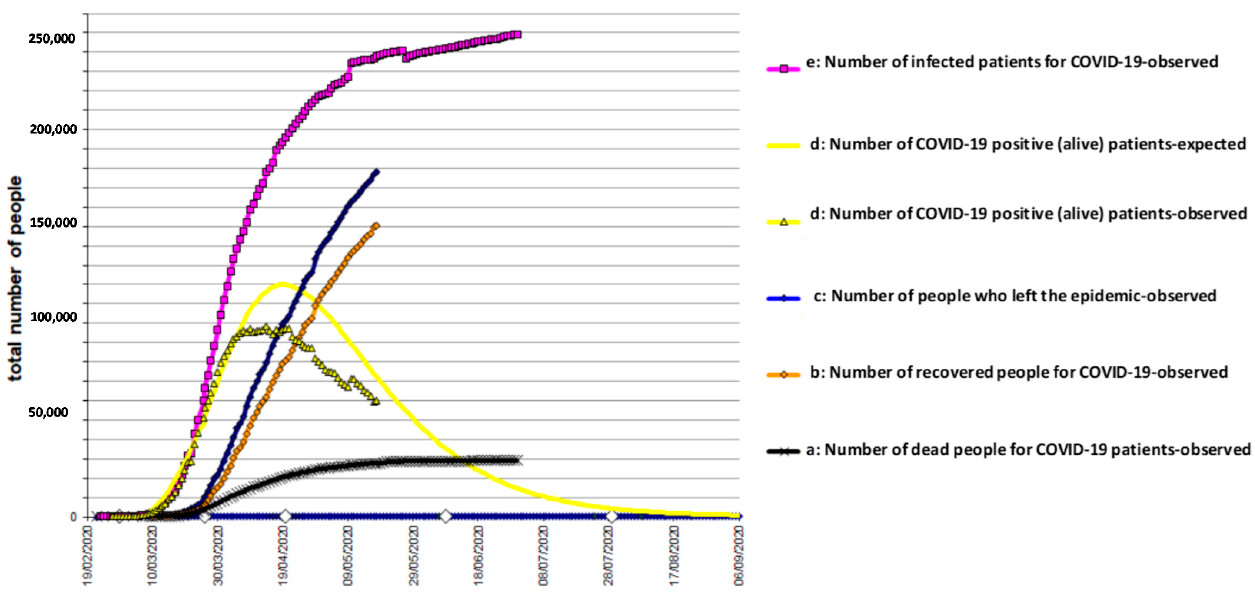
Figure 2. COVID-19 epidemic time-course in Spain.